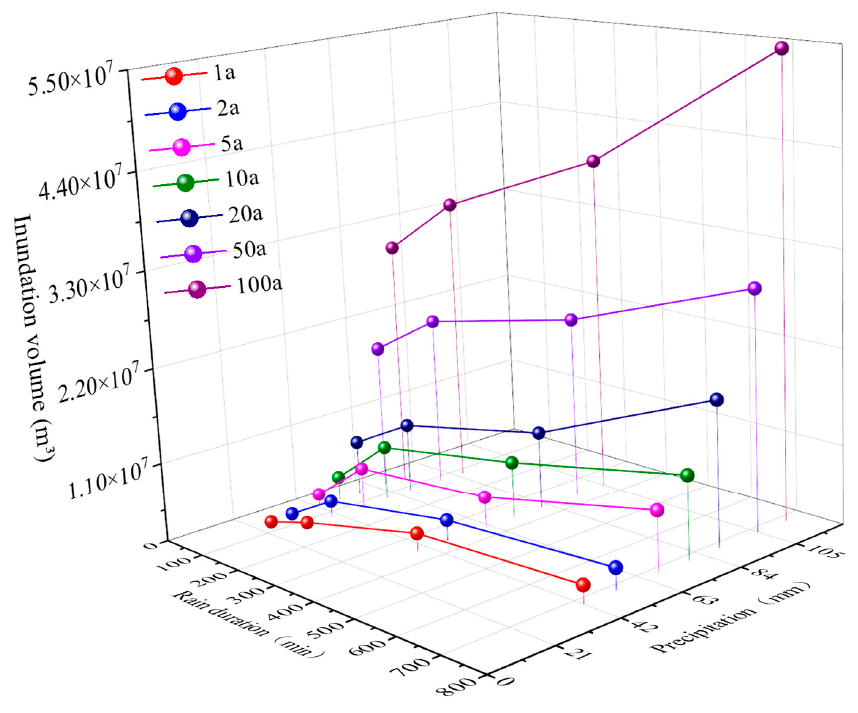
Figure 16. The relationship between submerged water volume and rainfall duration and rainfall.